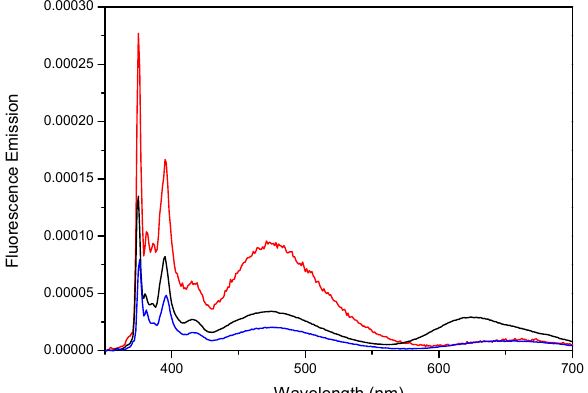
Figure 13. Emission spectra of the Ru(II) trisbipyridine complexes [Ru(Bpy) 2 (Bpy-Py2)] 2+ (black) in acetonitrile and [Ru(Bpy-Py2) 3 ] 2+ (blue) and [Ru(BpyG1-Py4) 3 ] 2+ (red) in THF. “Reprinted from